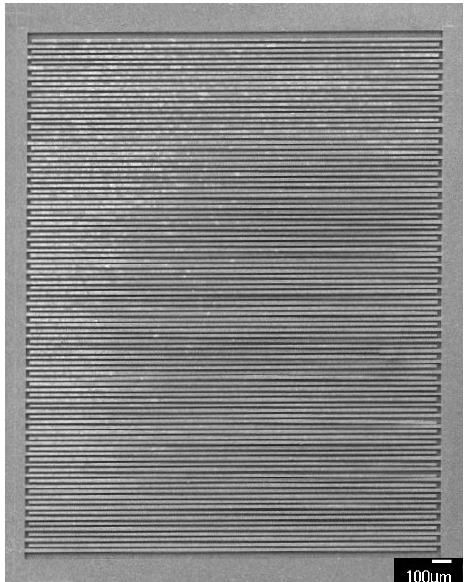
Figure 5. SEM image of the humidity sensor after the wet etching